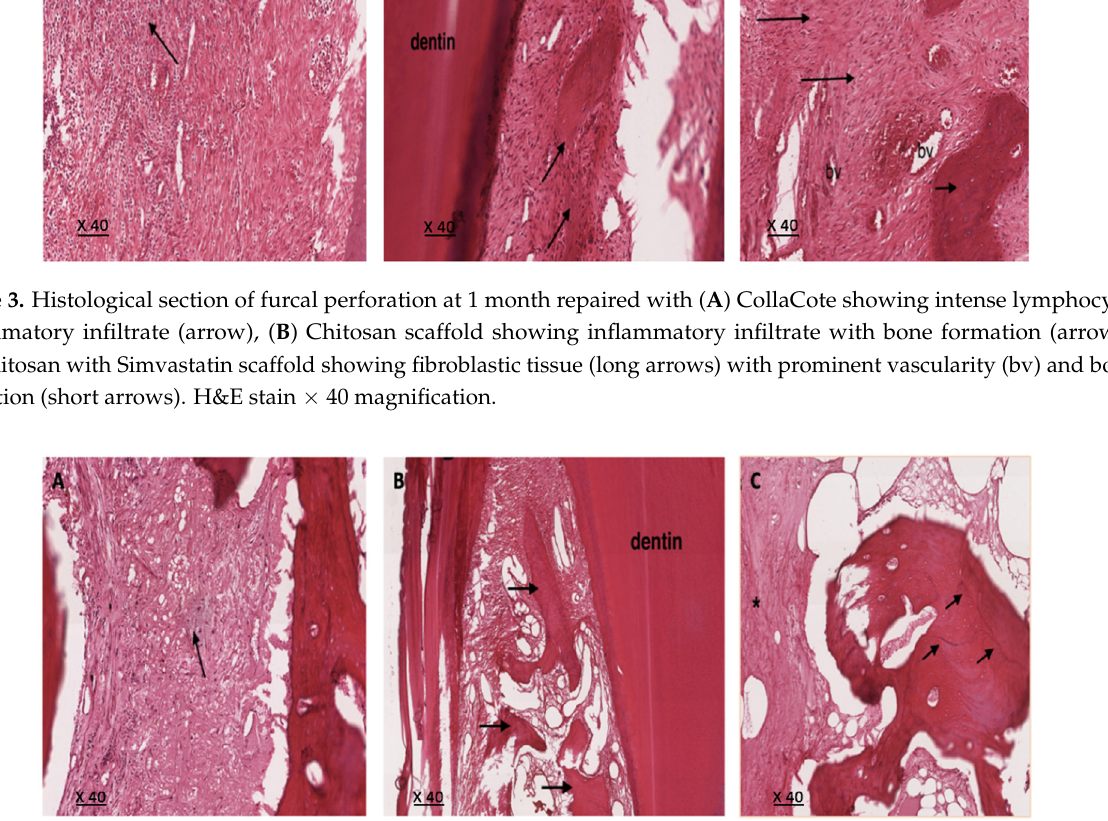
Figure 4. Histological section of furcal perforation at 3 months repaired with ( A ) CollaCote showing less inflammation and more fibrosis (arrow). ( B ) Chitosan scaffold showing more bone formation and maturation (arrows), ( C ) Chitosan with Simvastatin scaffold showing dense fibroblastic tissue (*) and bone trabeculae with prominent reversal lines (arrows). H&E stain (cid:3400) 40 magnification.